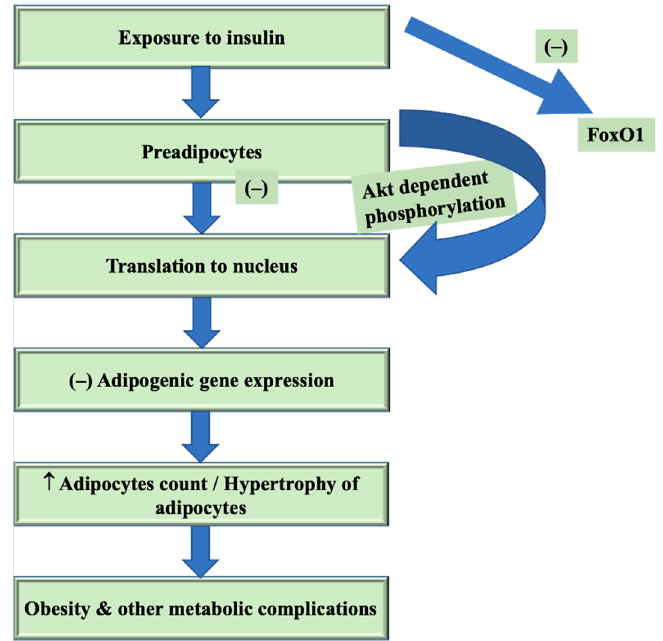
Figure 1. FoxO1 regulating metabolic processes and obesity. Legend: Akt—protein kinase B or PKB; FoxO1—forkhead box protein O1; (–)—inhibition; ↑ — increase.